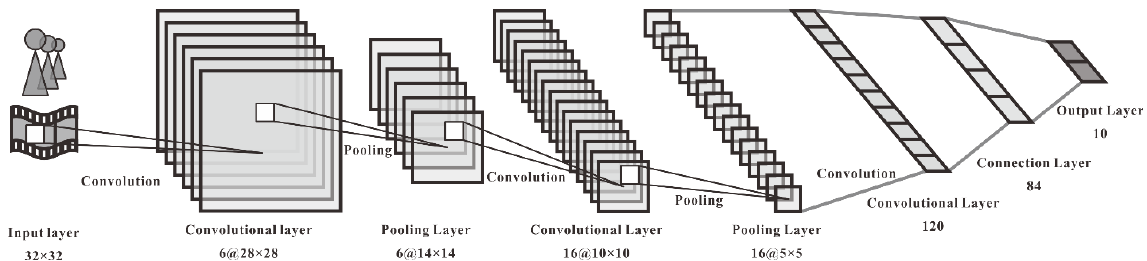
Figure 3. The CNN architecture in the proposed movie recommendation system.